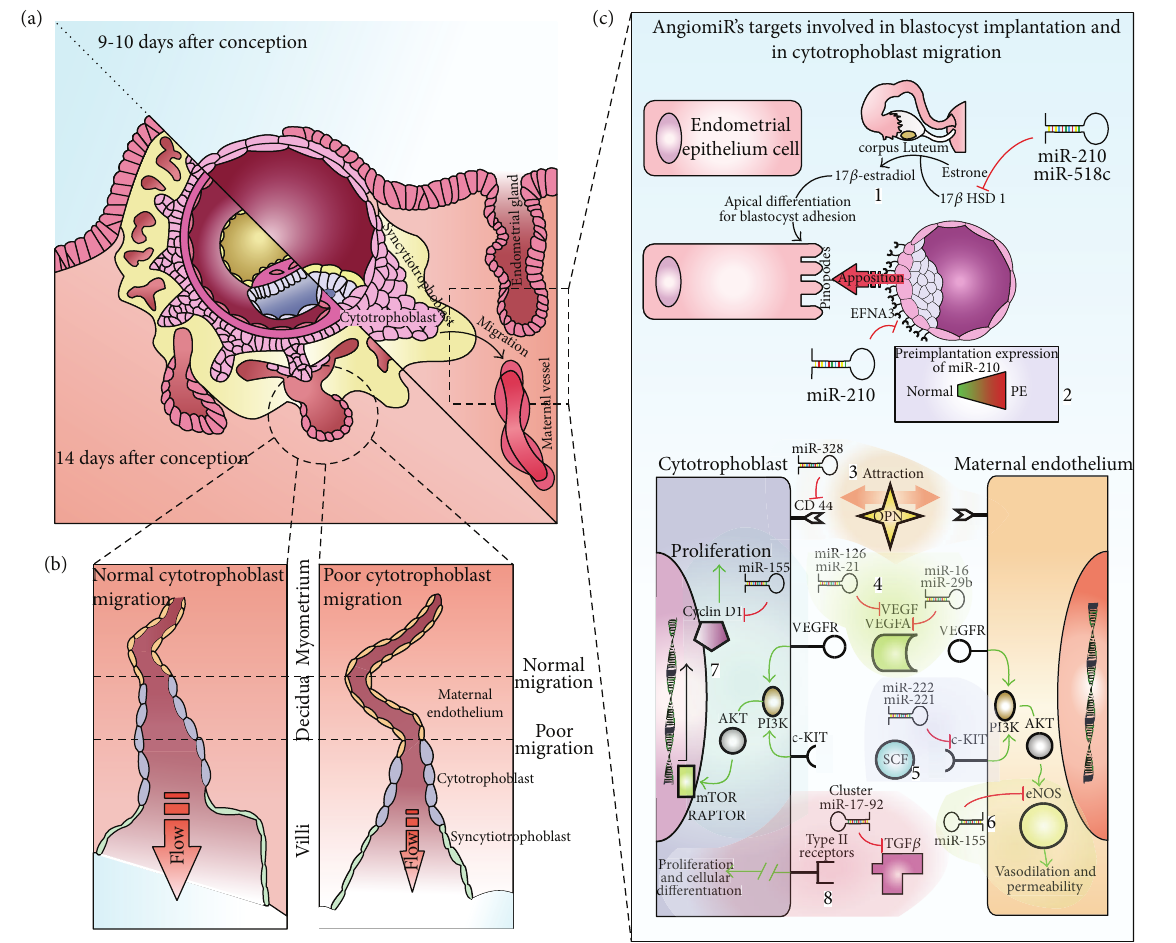
Figure 1: Some of the main roles of angiomiRs in placentation. Panel (a) shows key moments after blastocyst adherence to endometrial epithelium. On day 9, the trophoblast starts endometrium invasion which lasts until day 14 when primary villi start to form. Panel (b) represents cytotrophoblast invasion (migration and proliferation), which is responsible for increasing vascular capacity, showing how poor migration can decrease vessel transformation and induce increased blood pressure and decreased blood flow. Panel (c) shows some placental angiomiRs reported in PE, IUGR, and/or GD: Number 1 shows that before implantation 17 𝛽 HSD 1 enzyme transforms estrone to estradiol in the corpus luteum, inducing apical endometrial epithelial differentiation for blastocyst accession. 17 𝛽 HSD 1 is a validated target of miR-210 and miR-518c. Number 2 shows miR-210 regulation on EFNA3, the latter being expressed on trophoectodermal cells close to the inner cell mass of the blastocyst, guiding its location. In 1 and 2, it is possible to elucidate the potential problems that overexpression of miR-210 could cause, with evidence in PE. Number 3 shows miR-328 regulation on hyaluronate receptor CD44, which is involved in the cytotrophoblast and endothelial cells migration, in maternal vessels, in response to the OPN protein gradient’s attraction, released from endometrial gland. Number 4 shows miR-126 and miR-21 regulation on VEGF species, the vascular endothelial growth factor implicated in angiogenesis promotion, as well as miR-16 and miR-29b on VEGFA. Number 5 shows miR-222 and miR-221 regulating c-Kit; overexpression of these miRNAs produces an imbalance with its ligand SCF, with consequences on proliferative signal. Number 6 shows miR-155 downregulating eNOS, with possible damage on vasodilation and permeability; cyclin D1 (number 7) is a target of the same miR-155, generating problems on proliferation. Number 8 shows cluster miR-17-92 regulation on TGF 𝛽 , a key growth factor involved in cytotrophoblast proliferation and